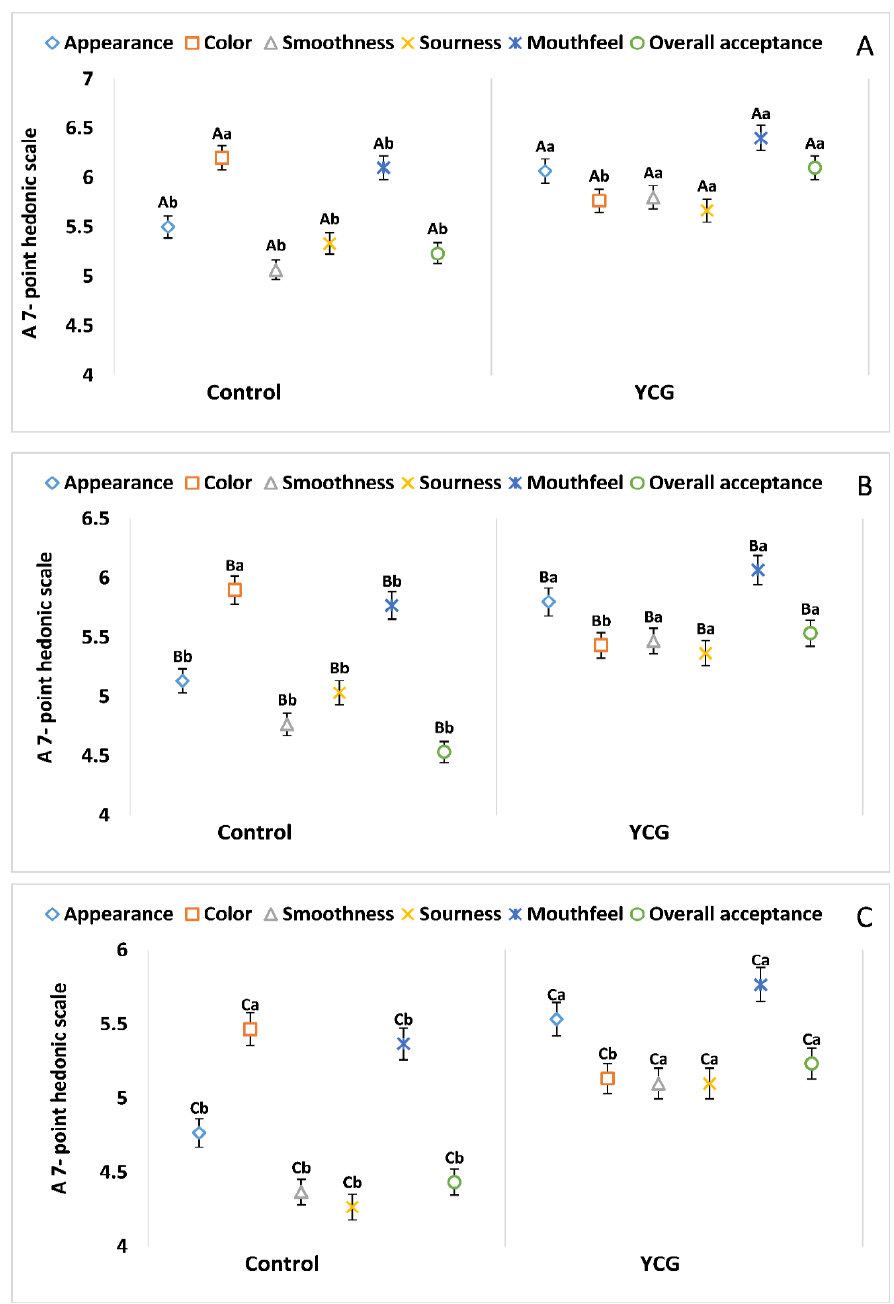
Figure 6. The average score of sensory evaluation of different yogurt types over storage periods. ( A ) zero-time, ( B ) 7 days of the storage period, and ( C ) 15 days of storage period. Different lowercase superscripts indicate significant ( p < 0.05) differences between the values for different treatments. Different uppercase superscripts indicate significant ( p < 0.05) differences between the values during the storage period. Error bars represent the standard division of means.